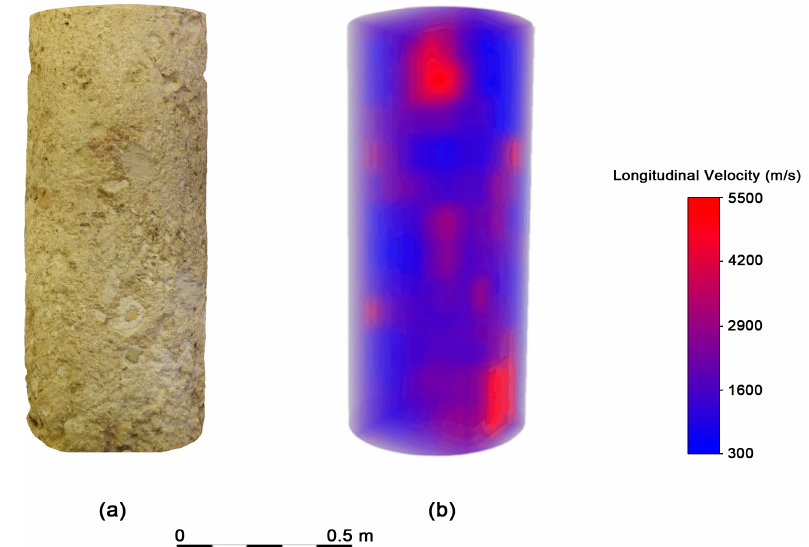
Figure 9. (a) Natural coloured textured 3D model of the column derived from CRP; (b) 3D ultrasonic tomography for the central column of the Saints Lorenzo and Pancratio